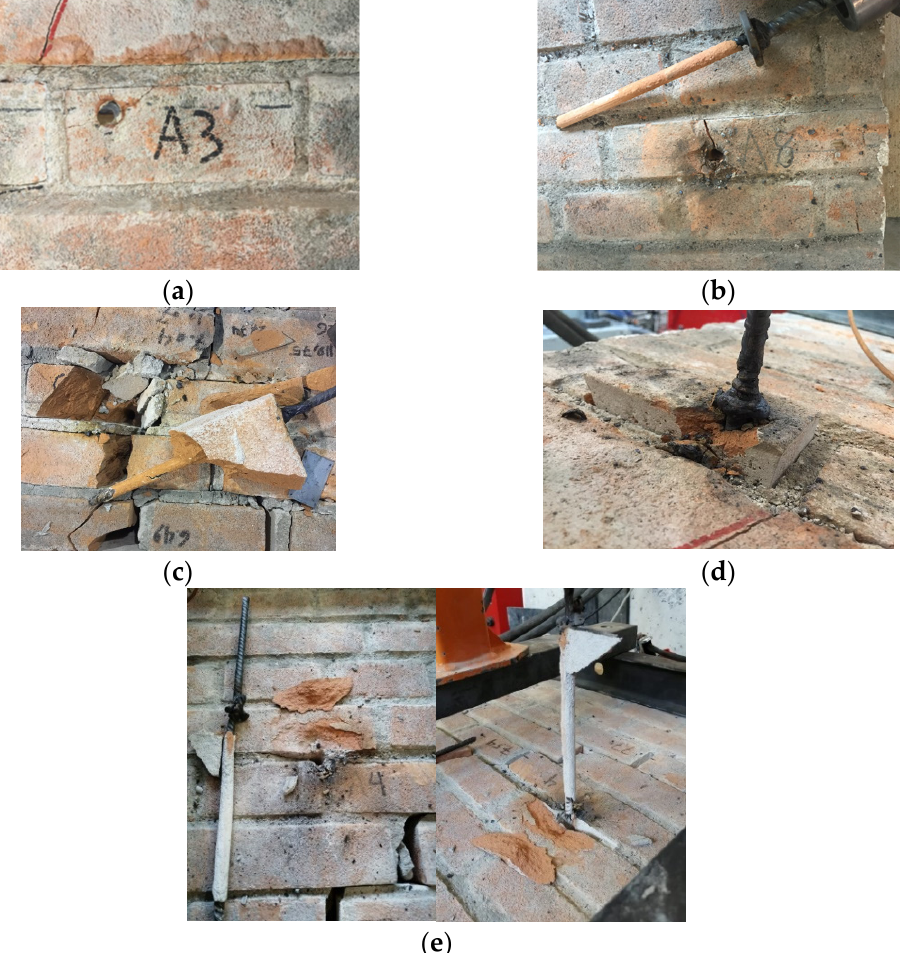
brick or cone failure, while in some cases pull-out of the brick was observed (Figure 6).